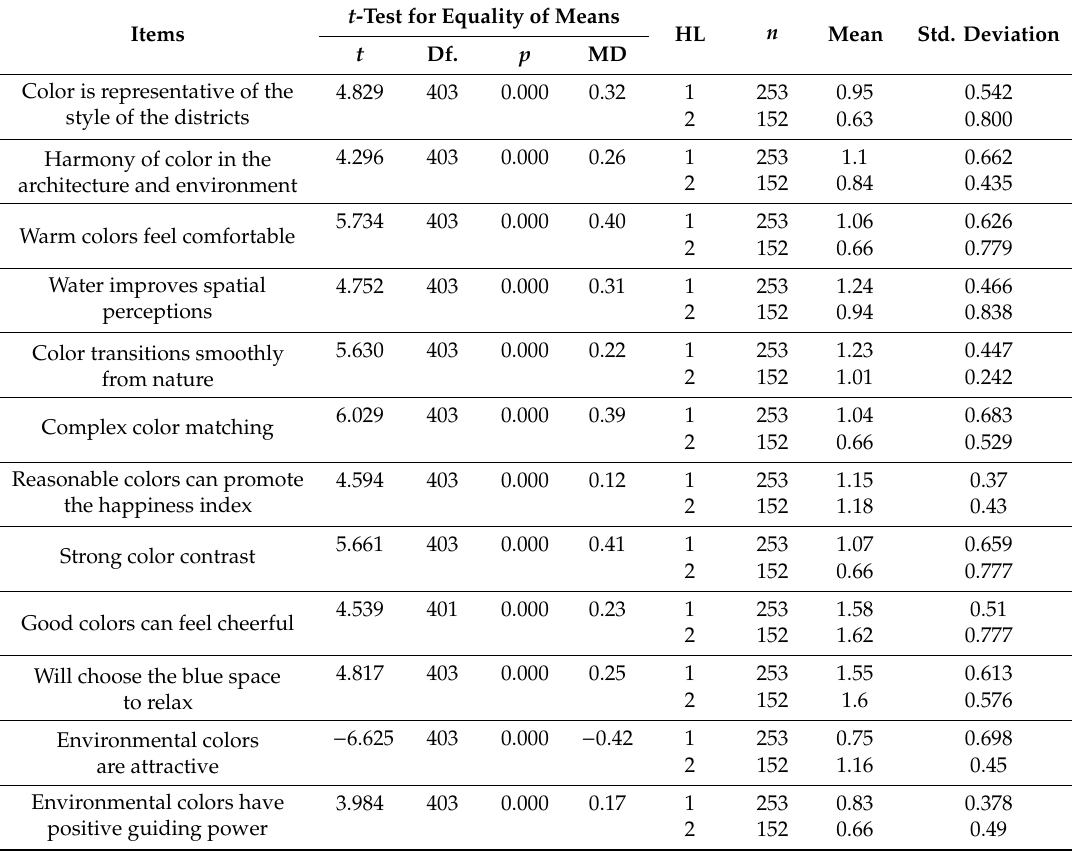
Table 8. One-sample t